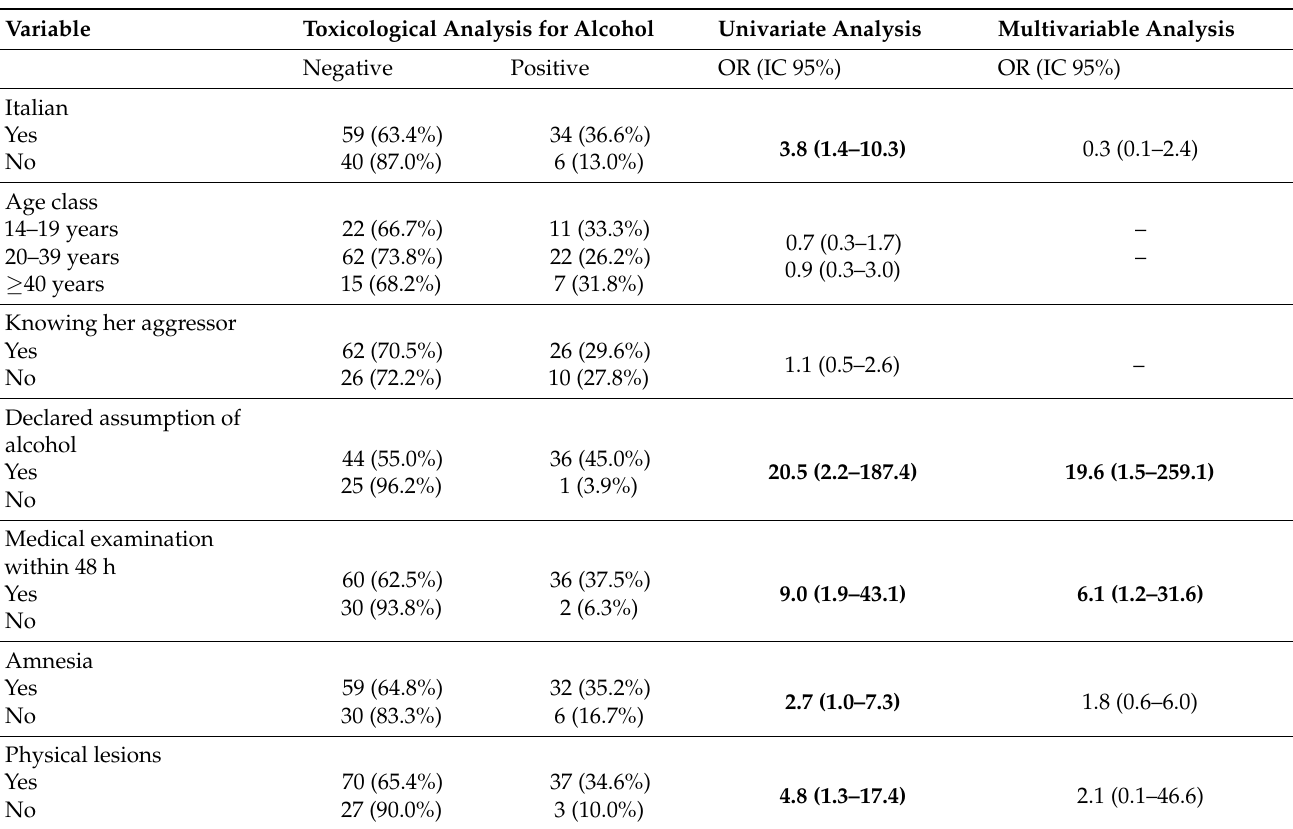
Table 7. Factors associated with a positive toxicological finding for alcohol at univariate and multi- variable